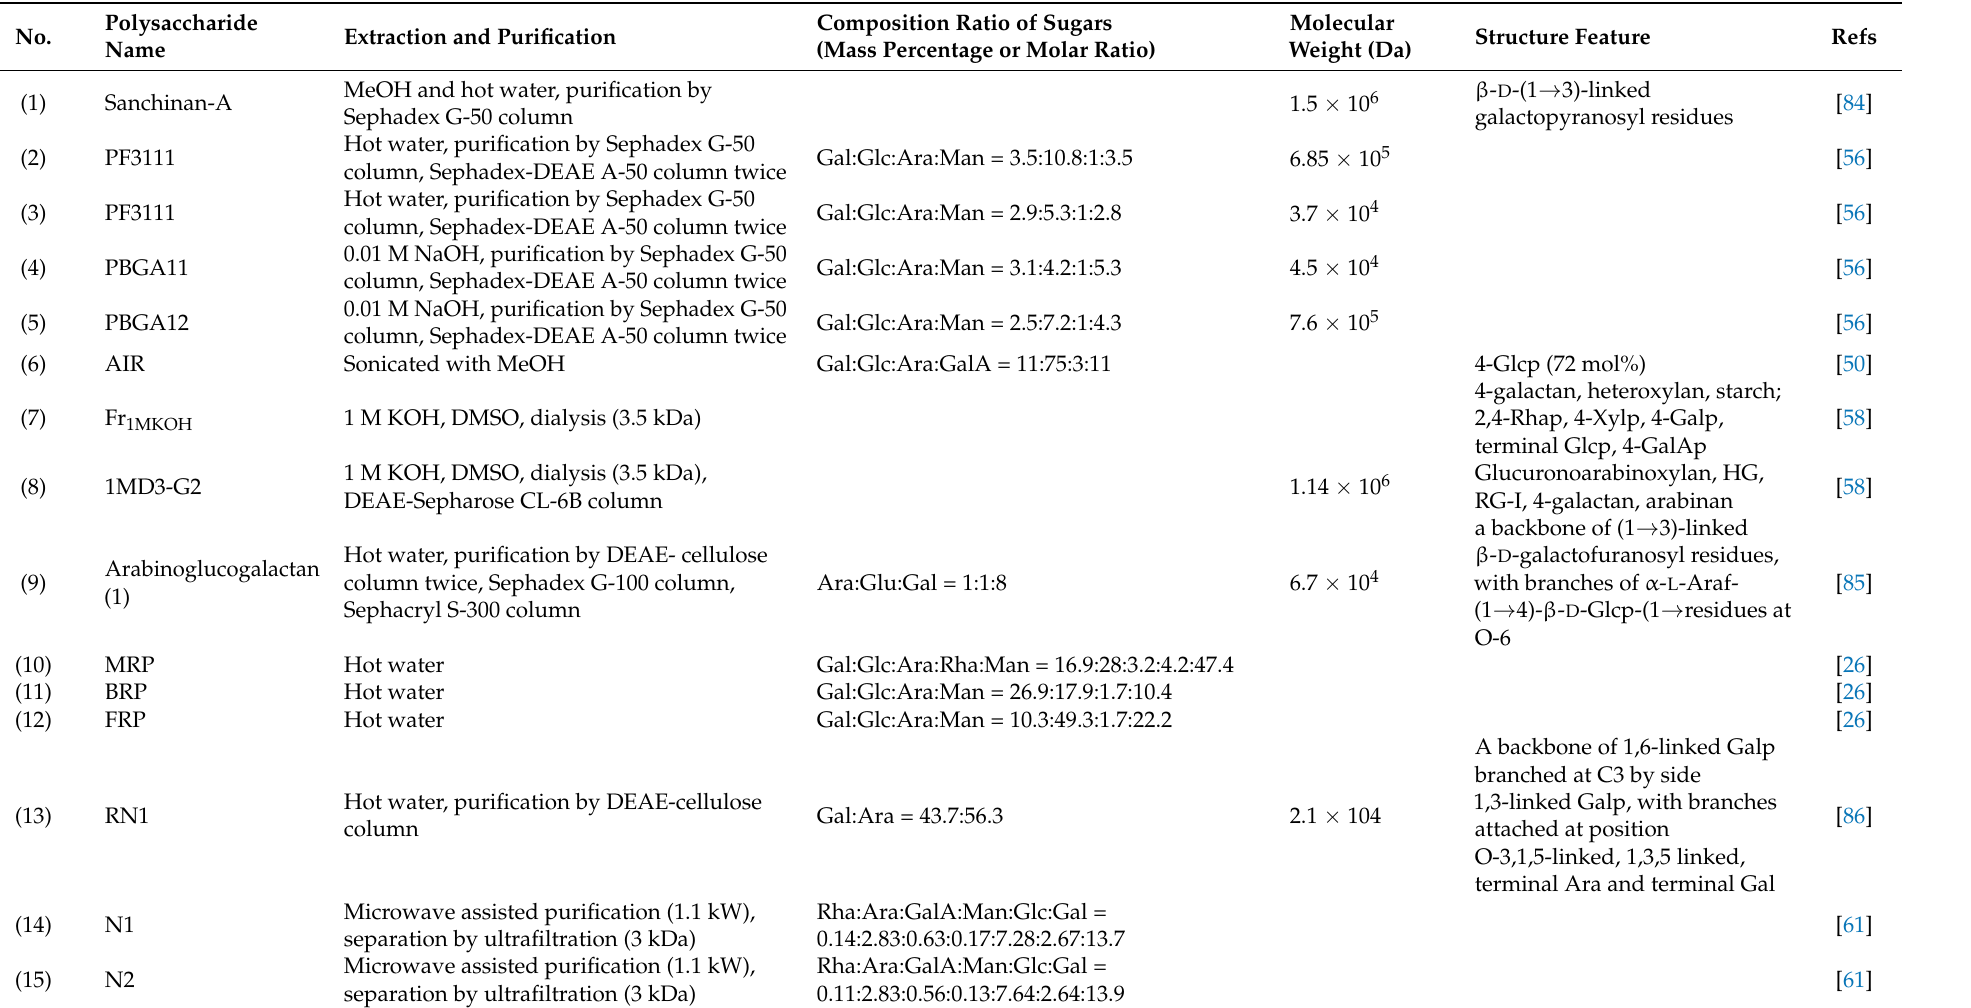
Table 3. Structure and composition of notoginseng